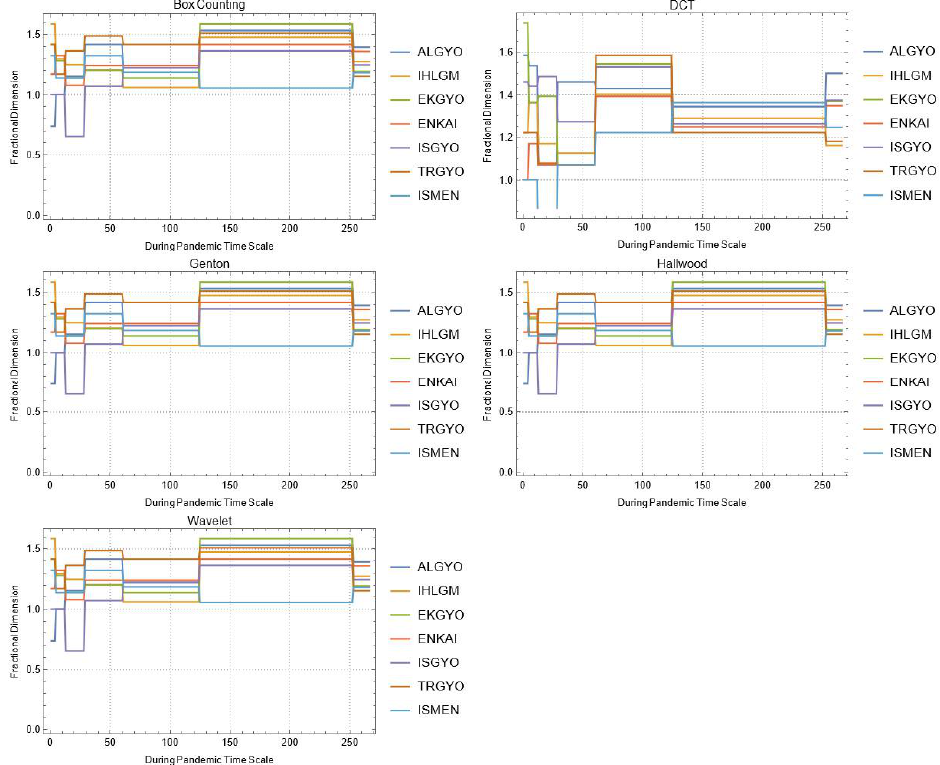
Figure A3. Daily changes of fractal dimensions during the pandemic (real estate).